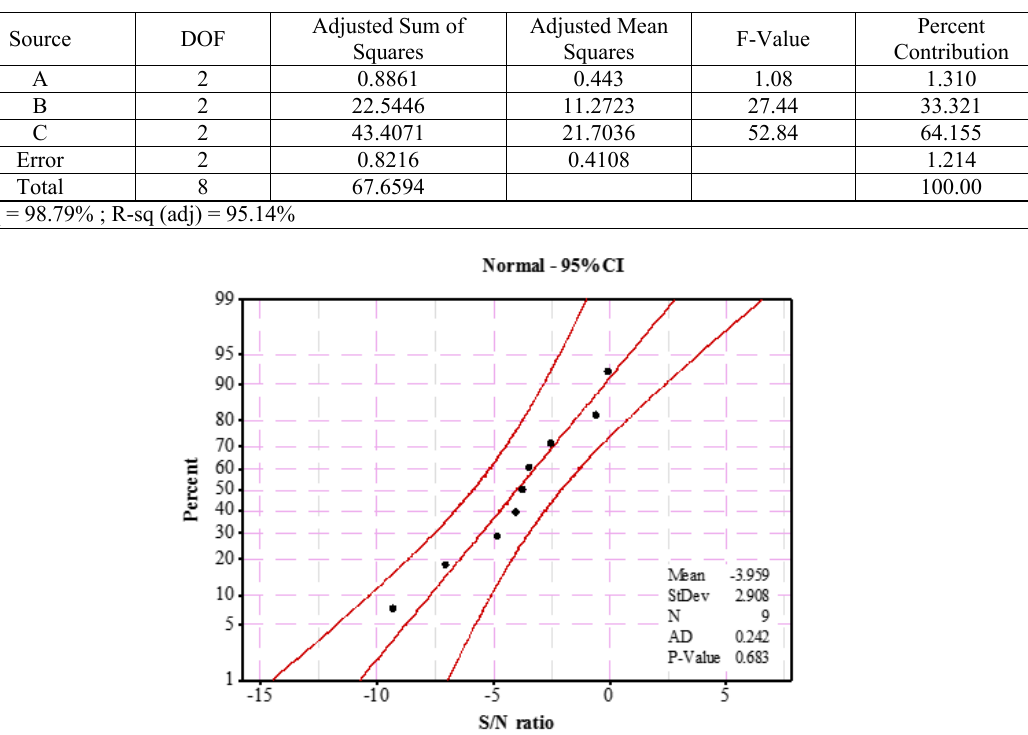
Figure 5. Probability plot of S/N